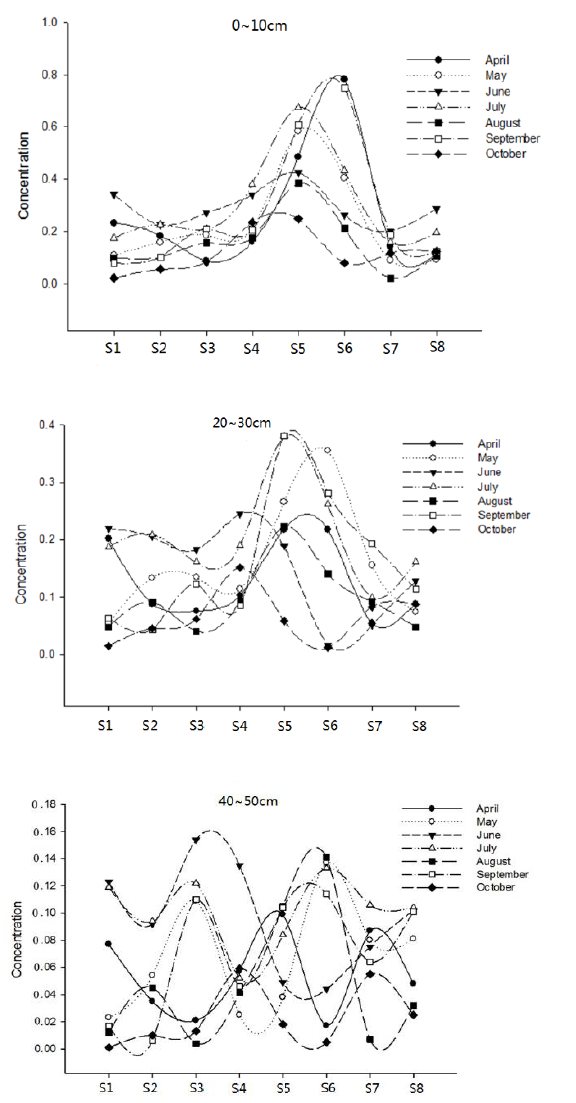
Figure 3. Horizontal distribution of TP content in different depths. Table 4. Difference analysis in different sites.